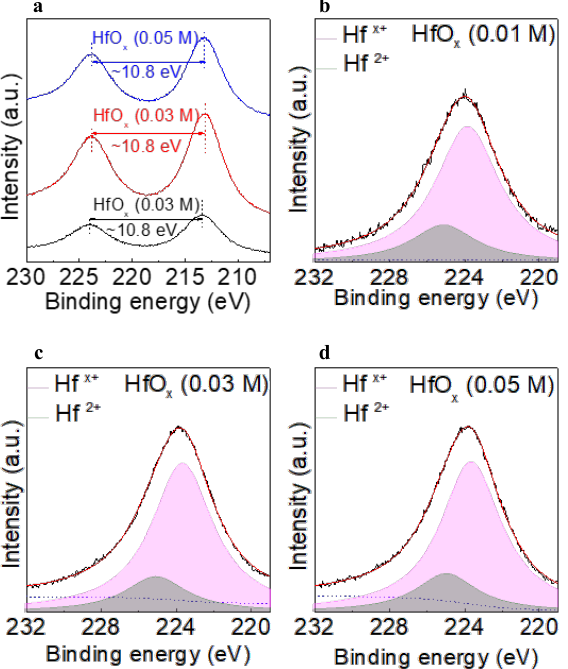
Figure 3. ( a ) Hf 4d spectra of HfO x (0.01 M), HfO x (0.03 M), and HfO x (0.05 M) films. Deconvoluted Hf 4d 3/2 XPS profiles of the ( b ) HfO x (0.01 M), ( c ) HfO x (0.03 M), and (d) HfO x (0.05 M) films.